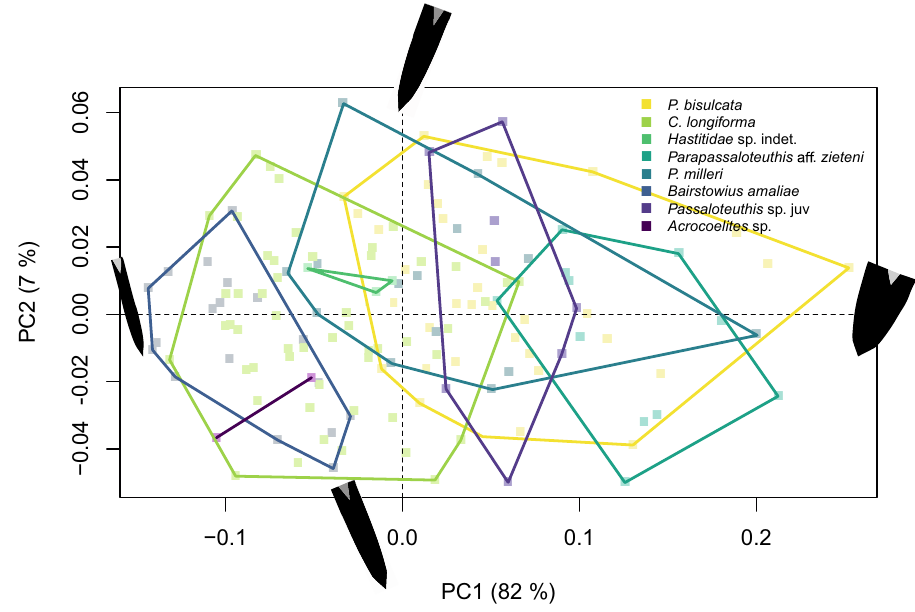
Figure 2. Subspace occupation within the two-dimensional morphospace (PC1, PC2) of the taxa present in this study. Points represent specimens and are coloured by taxon. The convex hulls connect the outermost values on PC1 and PC2 of each individual taxon. The black shapes around the figure represent the maximum and minimum shapes of the sagittal section through the belemnite rostrum of PC1 and PC2. (see sample sizes